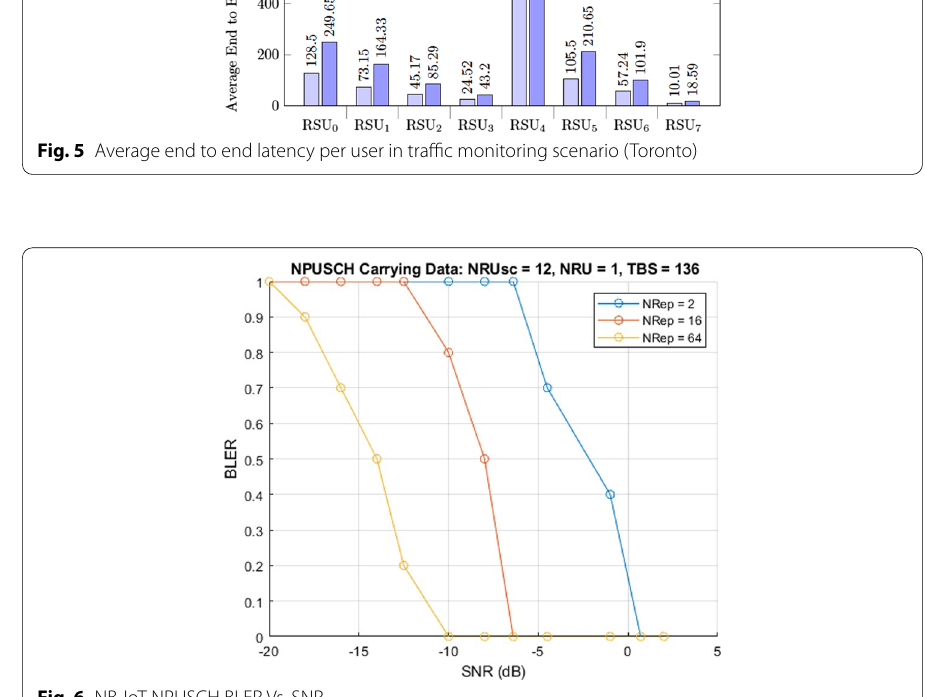
Fig. 6 NB-IoT NPUSCH BLER Vs.